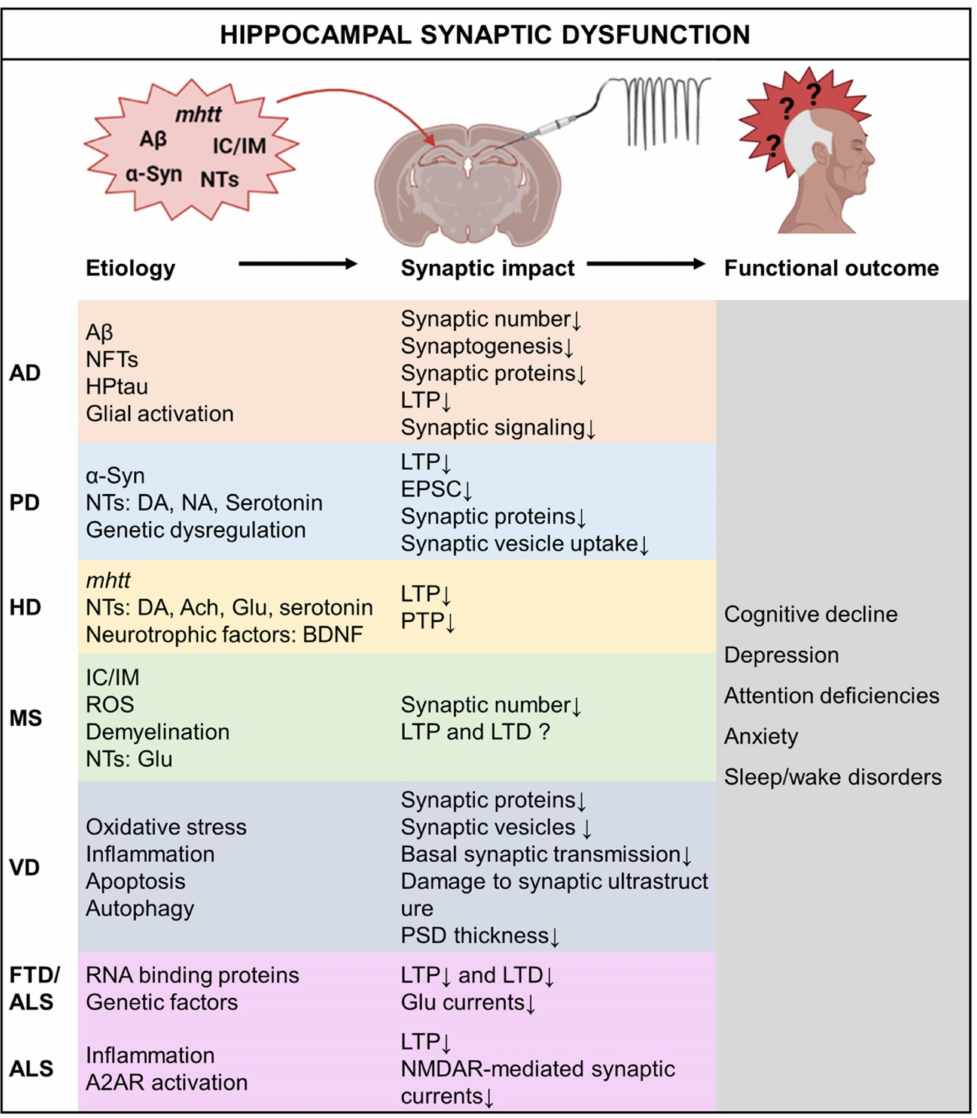
Figure 1. Schematic flow diagram of the correlation between etiopathogenesis and hippocampal synaptic dysfunction in neurodegenerative diseases. In neurodegenerative diseases, several etiologi- cal factors impact hippocampal synaptic plasticity, leading to functional outcomes such as cognition and emotional dysregulations. Abbreviations: Ach, acetylcholine; A2AR, adenosine A 2A receptor; AD, Alzheimer’s disease; α -Syn, alpha-synuclein; A β , amyloid beta; ALS, amyotrophic lateral sclero- sis; BDNF, brain-derived neurotrophic factor; DA, dopamine; EPSC, excitatory post-synaptic current; FTD, frontotemporal dementia; Glu, glutamate; HD, Huntington’s disease; HPtau, hyperphospho- rylated Tau; IC, inflammatory cells; IM, inflammatory mediators; LTD, long term depression; LTP, long term potentiation; mhtt , mutant-huntingtin; MS, multiple sclerosis; NA, noradrenaline; NFTs, neurofibrillary tangles; NMDAR, N-methyl-D-aspartate receptors; NTs, neurotransmitter systems; PD, Parkinson’s disease; PSD, post-synaptic density; PTP, post-tetanic potentiation; ROS, reactive oxygen species; VD, vascular